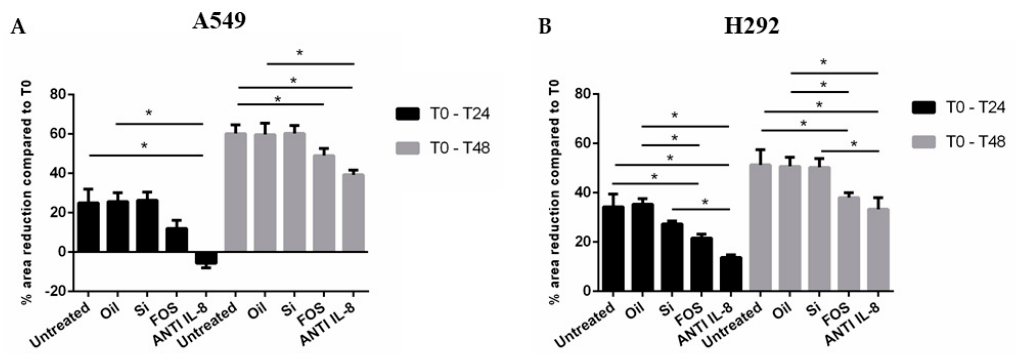
Figure 1. Effects of FOS in cell migration. A549 ( A ) and NCI-H292 ( B ) were stimulated with fish oil, silica, FOS (10 μ g/mL), and anti-IL-8 for 24 and 48 h, and cell motility was assessed using the wound-healing test. We used anti-IL-8 (1 μ g/mL) to further demonstrate the central role in the cell migration of this cytokine. The results were expressed as a percentage of area reduction at 24 h and 48 h compared to time point 0 h (n = 3) ± SD. The comparison between different experimental conditions was evaluated by ANOVA corrected with Fisher’s test. * p < 0.05 was accepted as statistically significant.